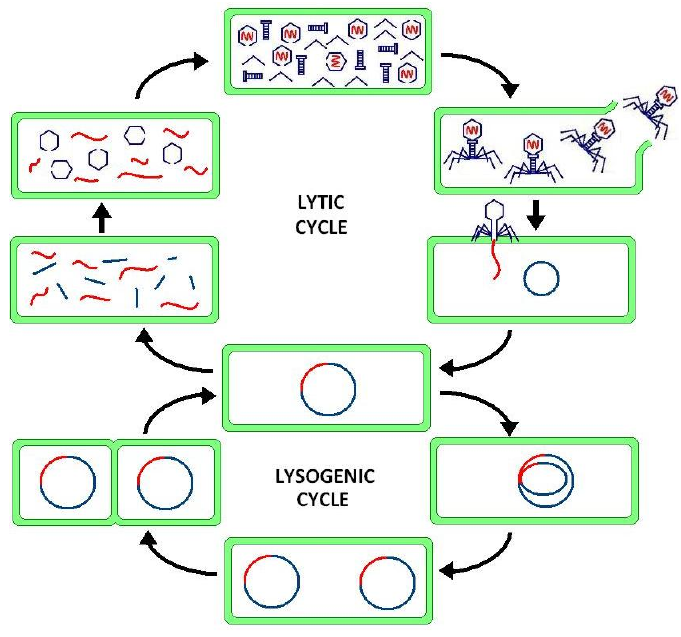
Figure 6. Lytic-lysogeny cycles (GNU Free Documentation License 1.2).